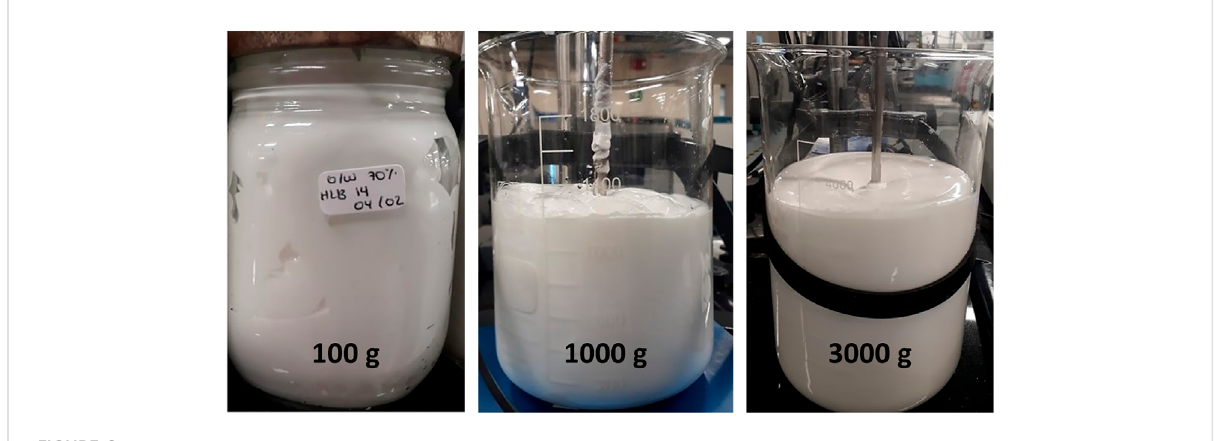
FIGURE 6 ImagesofO/Wemulsionspreparedat70%wt.andHLBof14.Theexperimentswereconductedatthreedifferentscales:fromlefttoright:100 g, 1,000 g and 3,000